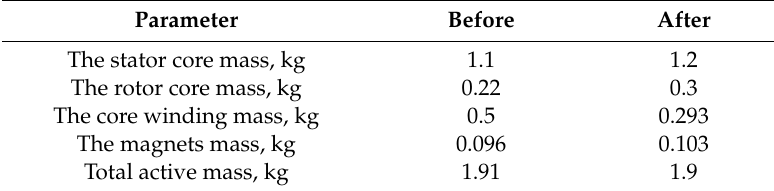
Table 5. Active material masses of the three-phase FRM before and after optimization. Parameter Before After